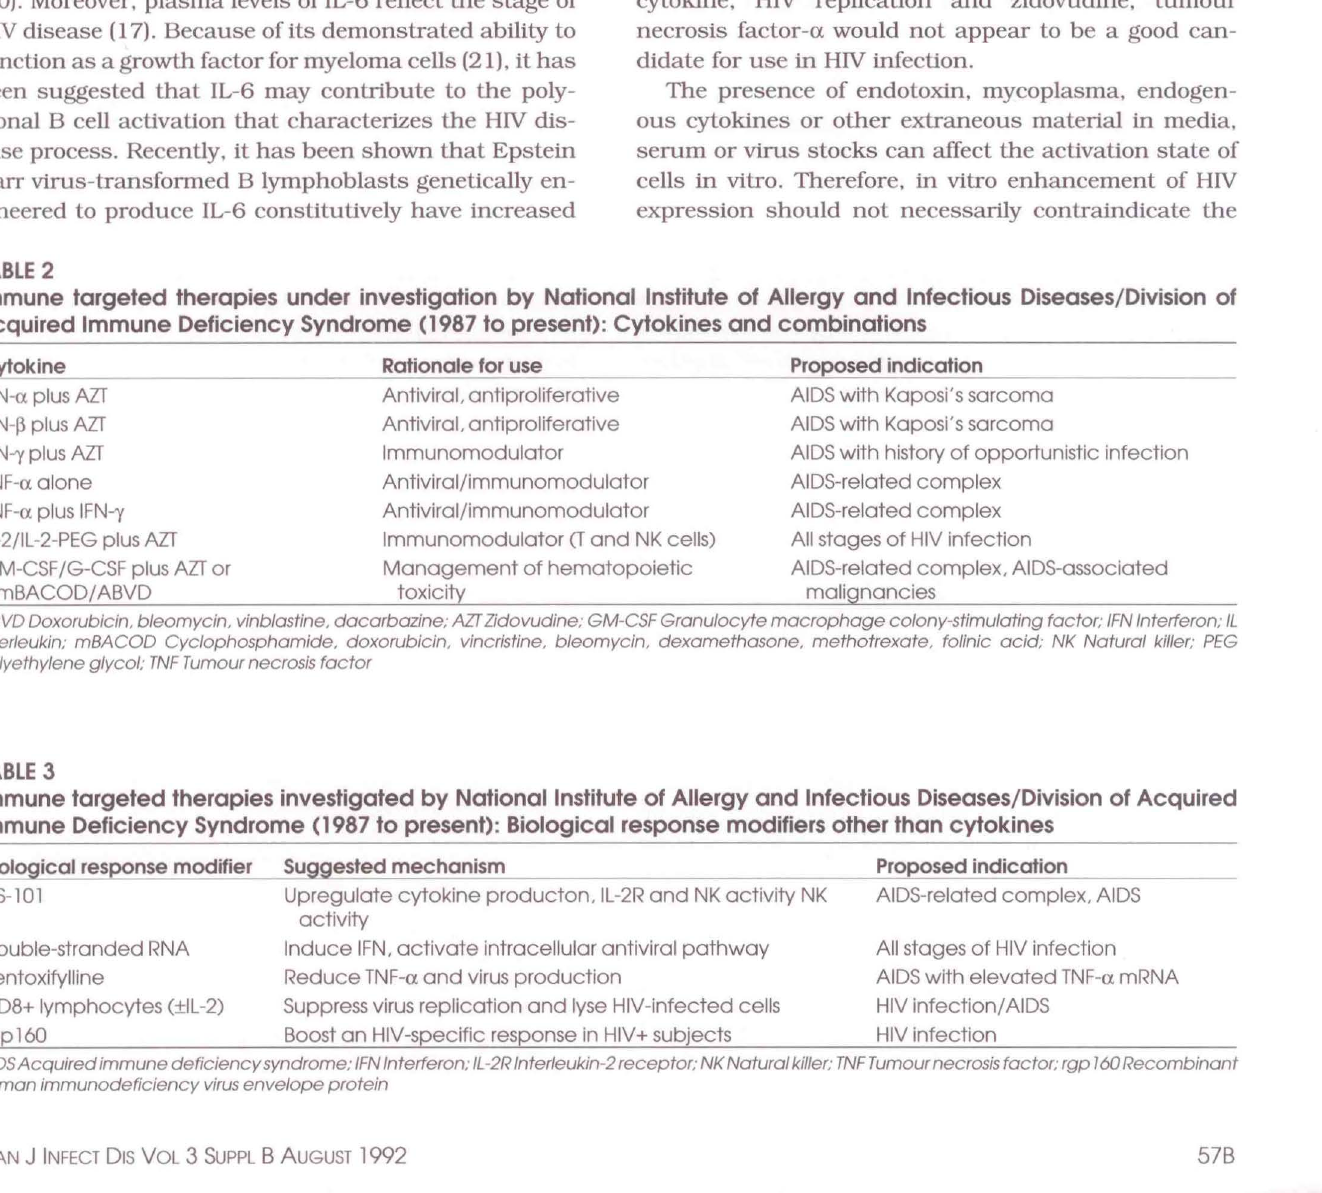
Immune targeted therapies investigated by National Institute of Allergy and Infectious Diseases/Division of Acquired Immune Deficiency Syndrome (1987 to present): Biological response modifiers other than cytokines